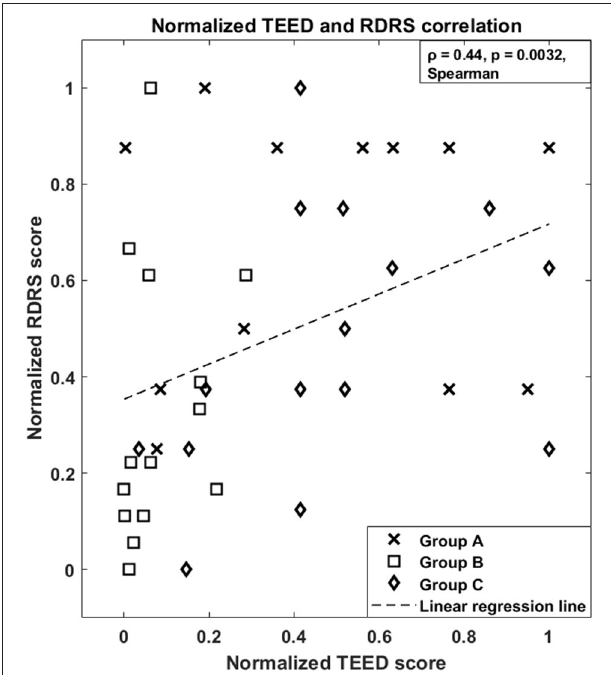
FIGURE 2 | Normalized Total Electrical Energy Delivered to the tissue, aTEED, and normalized Rush Dyskinesia Rating Scale, RDRS, correlation of the three studies. Group A: ( 5), N = 12; Group B: (6), N = 14; Group C: in press, N = 15 (total N = 41). The dashed line represents the estimated linear